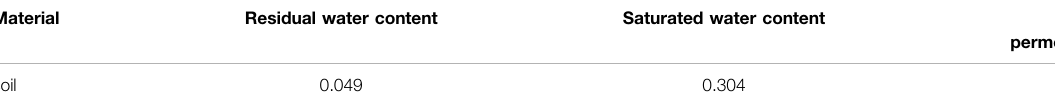
TABLE 2 | Hydraulic parameters of soil.